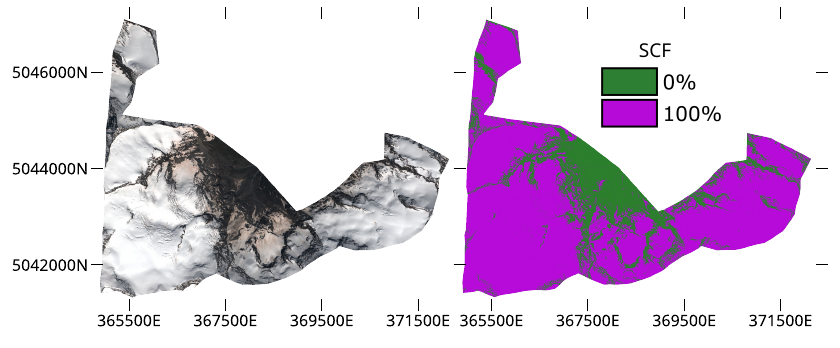
Figure A3. ( Left ): WorldView-2 true colour composite taken on 6 August 2021 (reference № 3 in Table A2). ( Right ): Binary snow classification of the left-side image.